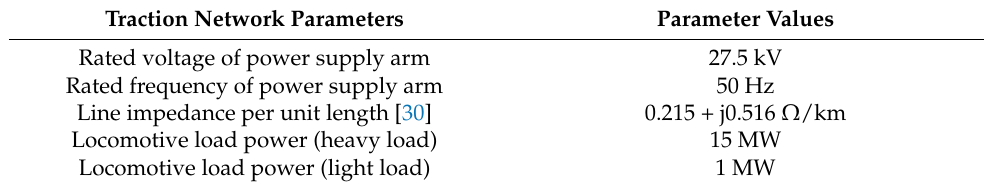
Table 1. Traction network parameters.